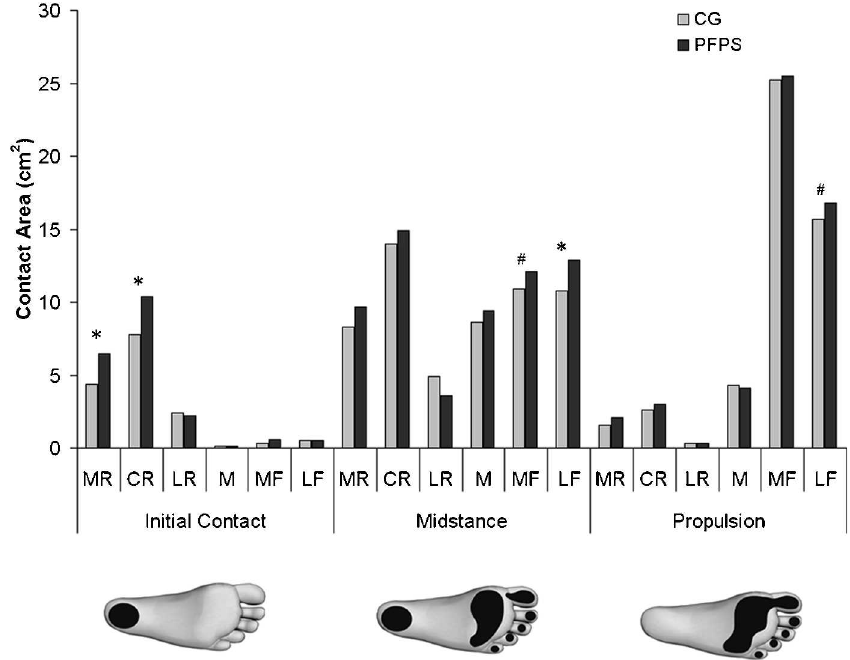
Figure 3 - Mean values of the contact area (cm 2 ) in six plantar areas (MR=medial rearfoot, CR=central rearfoot, LR=lateral rearfoot, M=midfoot, MF=medial forefoot and LF=lateral forefoot) during initial contact, midstance and propulsion. (CG=control group, PFPS=patellofemoral pain syndrome, * p , 0.05, # p , 0.1).